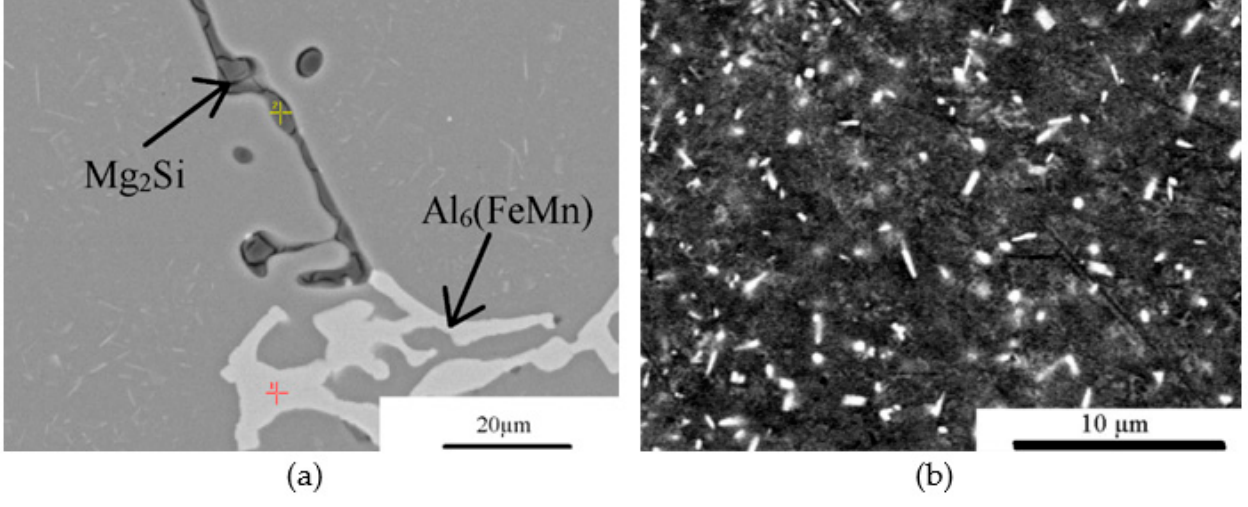
Figure 4. Second phase particles in the homogenized state of the 1565 ch alloy: ( a ) intermetallic compounds; ( b ) dispersoids.